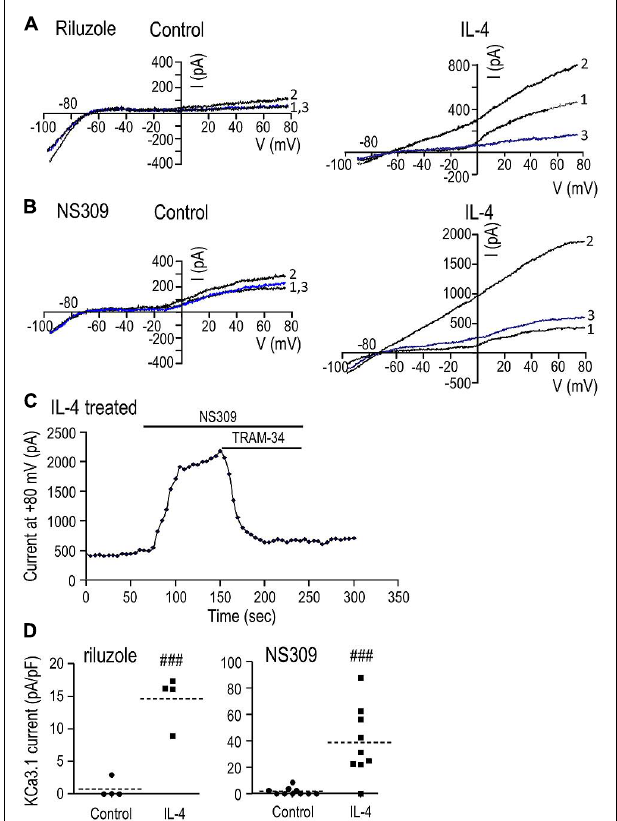
FIGURE 2 | IL-4 treatment induces a robust KCa3.1 current. (A,B) Representative currents in response to repeated voltage ramps from –100 to + 80 mV from a holding potential of –70 mV. Unstimulated microglia (left panels) were compared with cells treated for 24 h with 20 ng/ml of IL-4 (right panels). Each example shows superimposed currents in normal bath solution (traces labeled “1”), after adding a KCa channel activator (300 μ M riluzole or 500 nM NS309; traces labeled “2”), and after adding the selective KCa3.1 blocker, 1 μ MTRAM-34, in the continued presence of the channel activator (blue traces labeled “3”). (C) An example of the time course of current activation by NS309 (measured at + 80 mV; same IL-4-treated cell as B ) and block by 1 μ MTRAM-34. (D) A scatterplot of the TRAM-34-sensitive KCa3.1 component in each unstimulated and IL-4-treated microglial cell summarizes the KCa3.1 current density (pA/pF) and prevalence (proportion of cells expressing KCa3.1 current). Dashed lines indicate mean current densities (note differences in theY-axis scales). Statistical differences between control (unstimulated) and IL-4-treated microglia were determined by an unpaired t -test for each of the activators: ### p < 0.001.